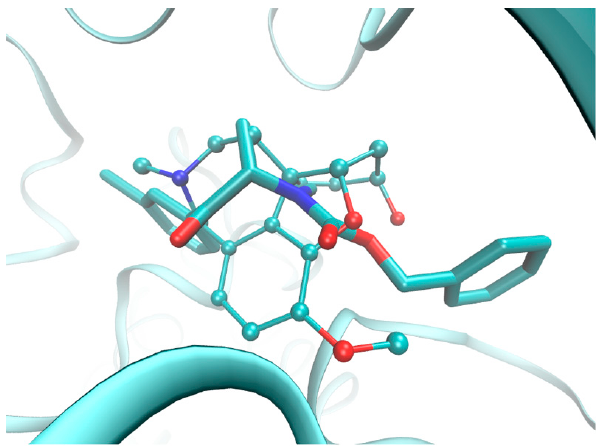
Figure 7. Structure of the BChE enzyme (displayed as ribbons) bound with GLT (depicted as balls and sticks), RIV (presented as thin sticks) and the most active molecule 28 (illustrated as thick sticks). Moreover, a run-through was performed to investigate the interacting mode for the most active compounds, which basically revealed two types of non-binding interactions: hydrophobic and hydrogen bond formation. Planar (2D) and spatial (3D) maps of the host–target interactions were created for all of the active compounds using Schrödinger Maestro software and the Protein-Ligand Interaction Profiler (PLIP) and were then compared with the drug (GLT and RIV) molecules [46]. Overall, the hydrophobic interactions were primarily generated with Asp70 (94%), Trp82 (28%), Pro285 (22%) and Tyr332 (22%), while Thr120 (83%) was basically specified as the hydrogen bond donor (HBD) that interacted with one of the oxygen atoms in the molecule carboxylic group. The 2D- and 3D-binding patterns for GLT, RIV and the most active BChE inhibitor ( 28 ) that was tested are illustrated in Figures 8 and 9, respectively. The hydroxyl substituent of Thr120 appeared to be crucial to form the hydrogen bond with the ether (Figure 9a,b) or carbonyl oxygen (Figure 9c). For the examined BChE inhibitors, the regions close to the nitrogen atom (R 1 substituent) seemed to be valid for the hydrophobic interactions with the Asp70 amino acid residue, which is in line with our previous receptor-independent findings (Figure 5). Figure 8. Planar (2D) comparision of the binding mode for: rivastigmine ( a ); galanthamine ( b ); and the most active BChE inhibitor 28 that was tested ( c ), as generated by the Maestro software.